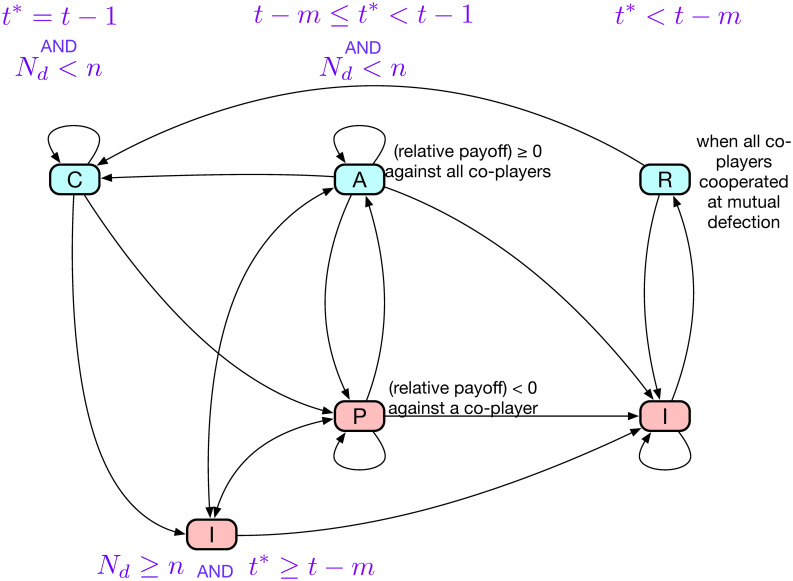
Schematic diagram of the transition between states of CAPRI-n.The five rules of the strategy can be identified with the player’s internal states [26], each of which is represented as a node in this diagram. An exception is state I, which corresponds to two nodes to clarify the following point: When t* ≥ t − m, the state may have outgoing connections to A and P. When t* < t − m, on the other hand, the only possible next state is R. The player has to choose c at a blue node and d at a red node. We have omitted error-caused transitions for the sake of simplicity.